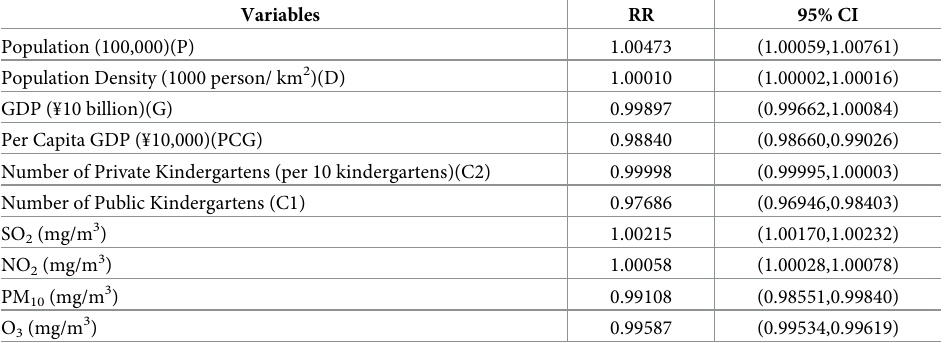
Table 5. Results of the regression coefficients for the multivariate Bayesian models with respect to the seven factor variables.